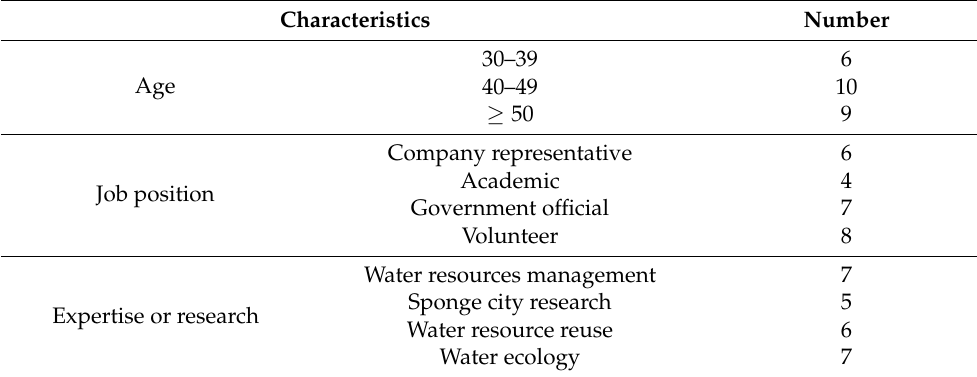
Figure 4. Evaluation model of urban water resilience. Table 2. Expert panel